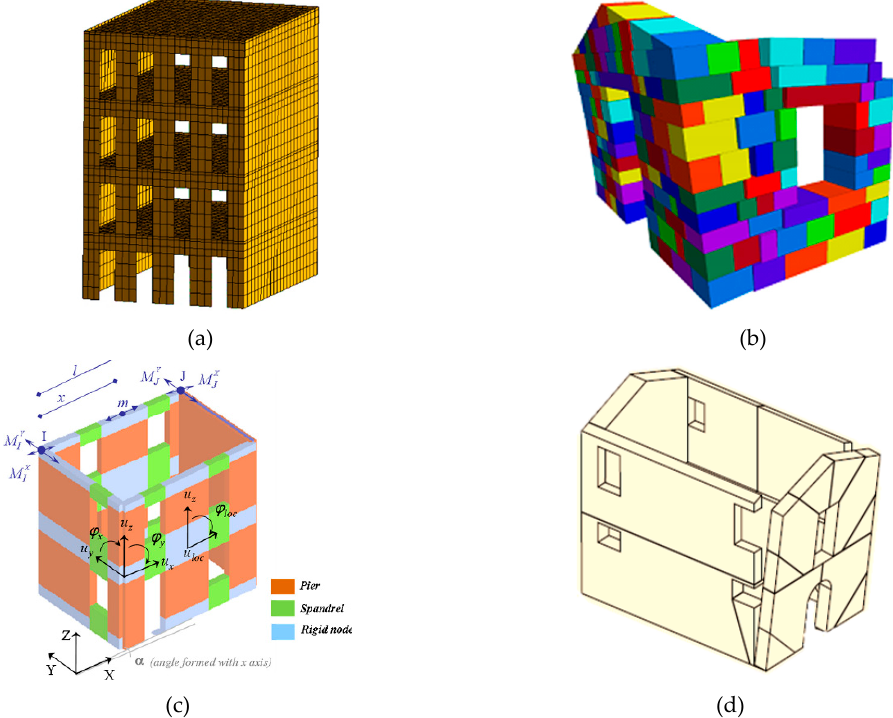
Figure 6. Examples of numerical model of masonry buildings using: ( a ) FEM [61], ( b ) DEM [50], ( c ) simplified equivalent frame method [62] and ( d ) method with rigid macroblocks taking into account the expected collapse mechanisms [63].